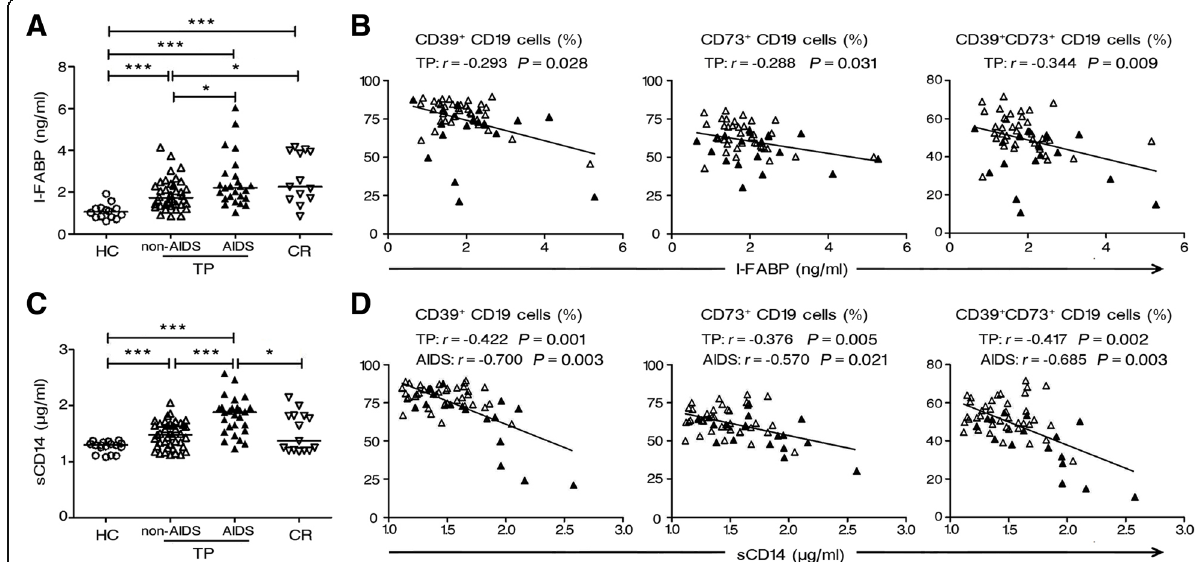
Fig. 4 Relationships between the frequencies of CD39 + , CD73 + , and CD39 + CD73 + B cells and plasma I-FABP and sCD14 levels. a Plasma levels of I-FABP in TPs ( n = 65), CRs ( n = 13), and HCs ( n = 14). b Correlation analysis between the percentages of CD39 + , CD73 + , and CD39 + CD73 + B cells and I-FABP plasma levels. c Plasma levels of sCD14 in TPs ( n = 68), CRs ( n = 15), and HCs ( n = 17). d Correlation analysis between the percentages of CD39 + , CD73 + , and CD39 + CD73 + B cells and sCD14 plasma levels. * p < 0.05, ** p < 0.01, *** p <